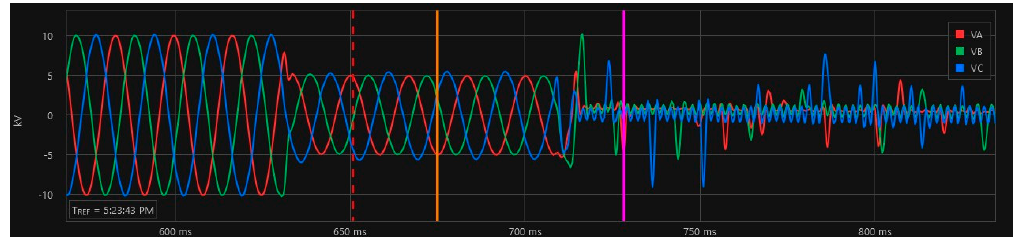
Figure 33. Phase currents recorded by R1 under definite-time scheme.